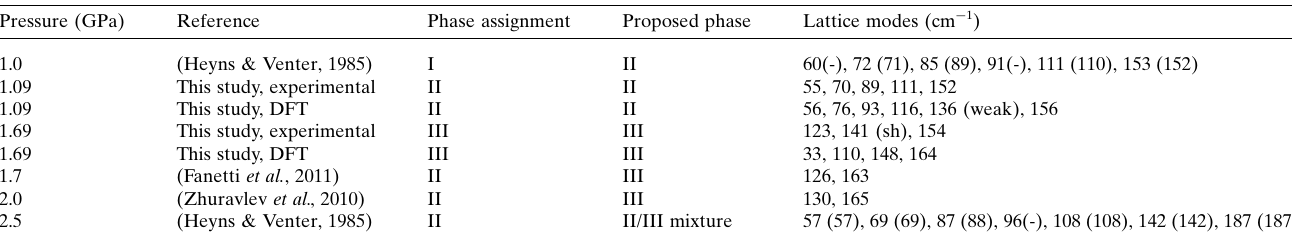
Table 4 Comparison of the Raman lattice modes in pyridine II and pyridine III. The values given for the Heyns & Venter study are taken from their Table 3 with values from their Fig. 1 in parentheses. Pressure